Question: Condense the content of this figure into a single sentence.
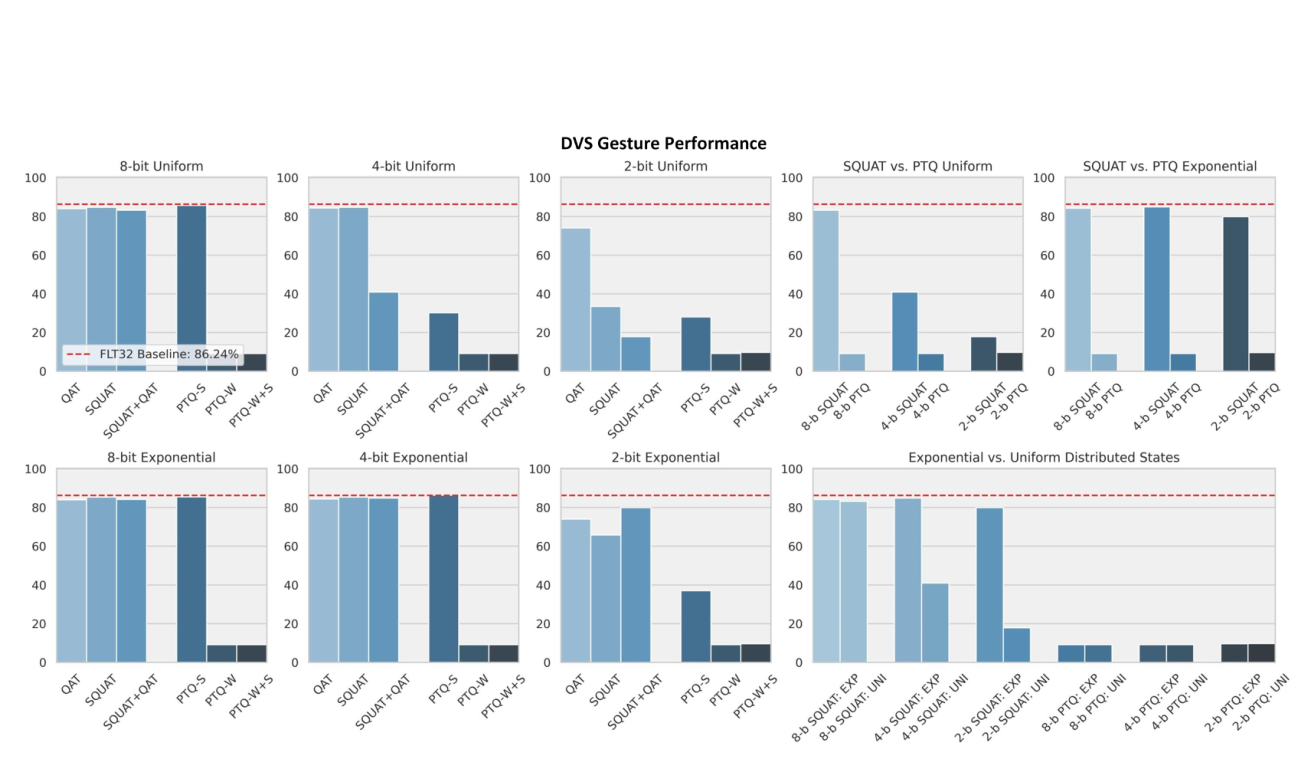
Answer: DVS Gesture Dataset performance. Top row: (i) 8/4/2-b uniformly distributed states across QAT (N-b weights, flt32 states), SQUAT (flt32 weights, N-b states), SQUAT+QAT (N-b weights, N-b states), and PTQ-S (flt32 weights, N-b states), PTQ-W (N-b weights, flt32 states), PTQ-W+S (N-b weights, N-b states). (ii) SQUAT vs PTQ uniformly and exponentially distributed states (SQUAT and QAT are both applied across N-b weights and states, and compared against PTQ of N-b states and weights). Bottom row: (iii) 8/4/2-b exponentially distributed states across QAT (N-b weights, flt32 states), SQUAT (flt32 weights, N-b states), SQUAT+QAT (N-b weights, N-b states), and PTQ-S (flt32 weights, N-b states), PTQ-W (N-b weights, flt32 states), PTQ-W+S (N-b weights, N-b states). (iv) Comparison between exponential and uniformly distributed states: SQUAT+QAT are used across N-b states and weights, then N-b PTQ is used across N-b states and weights.